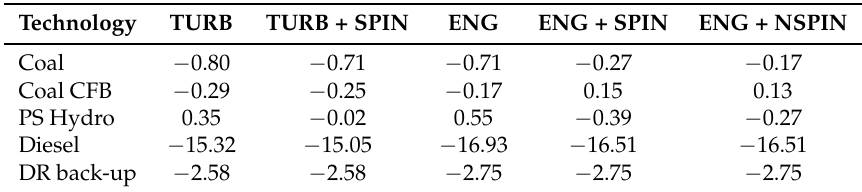
Table 2. Changes in the capacity factors of different technologies compared to no gas case. Reported units are in percentage points. PS: pump storage and DR: demand response.